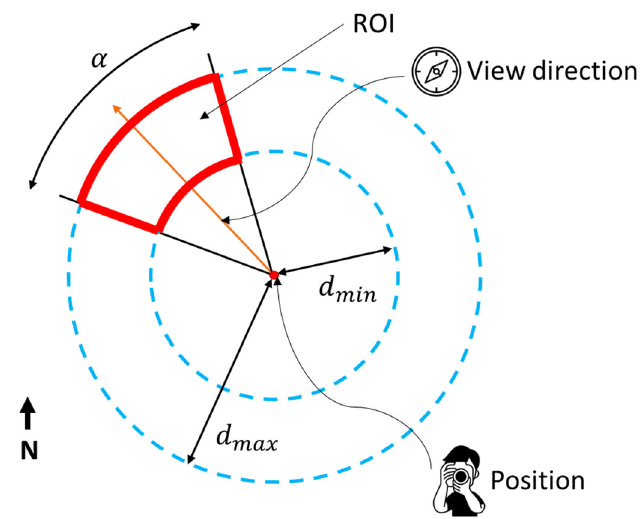
Figure 1. Definition of a single ROI for floodwater training sample construction starting from the position where the photograph is taken, the view direction, the view angle, and flooding minimum and maximum distance.